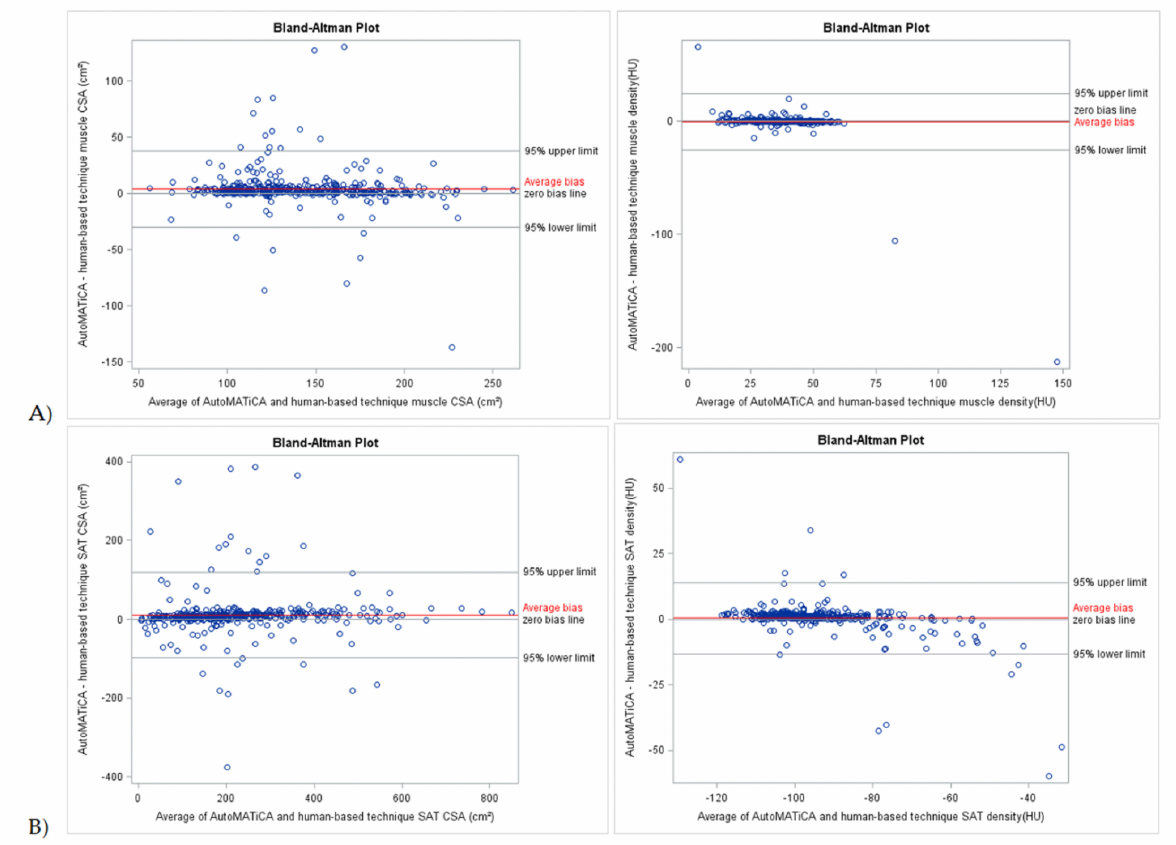
Figure 2. Bland-Altman plots of body composition parameters between test (AutoMATica) and reference (SliceOmatic plus ABACS + manual correction) method for entire sample. Plots show cross-sectional area (CSA) and density for muscle ( A ) and subcutaneous adipose tissue (SAT, B ). Limits of agreement within 1.96 standard deviations are shown with average bias (red line) for each